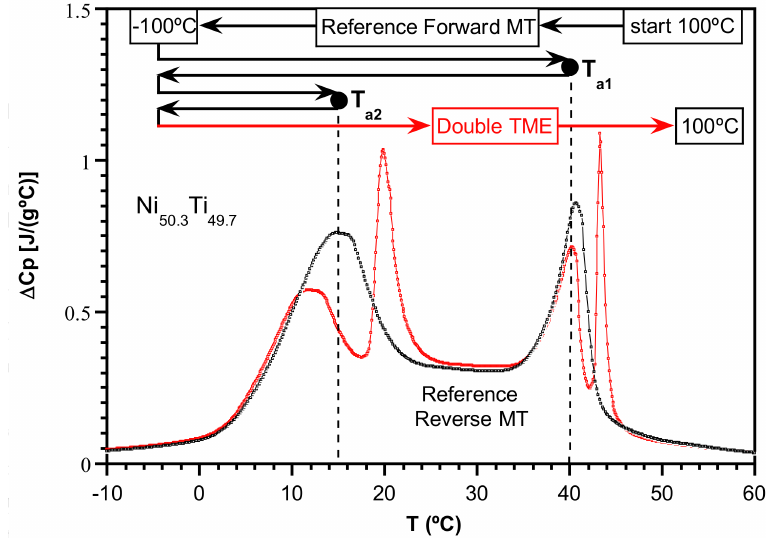
Figure 8. The thermal sequence, including two independent partial transformation cycles to T a1 and T a2 , are depicted in the top of this figure. Inside, the calorimetric curve clearly shows the presence of the temperature memory effect (TME) in both transformation stages (o: red). This result is compared with the “Reference Reverse MT” ( (cid:3) :